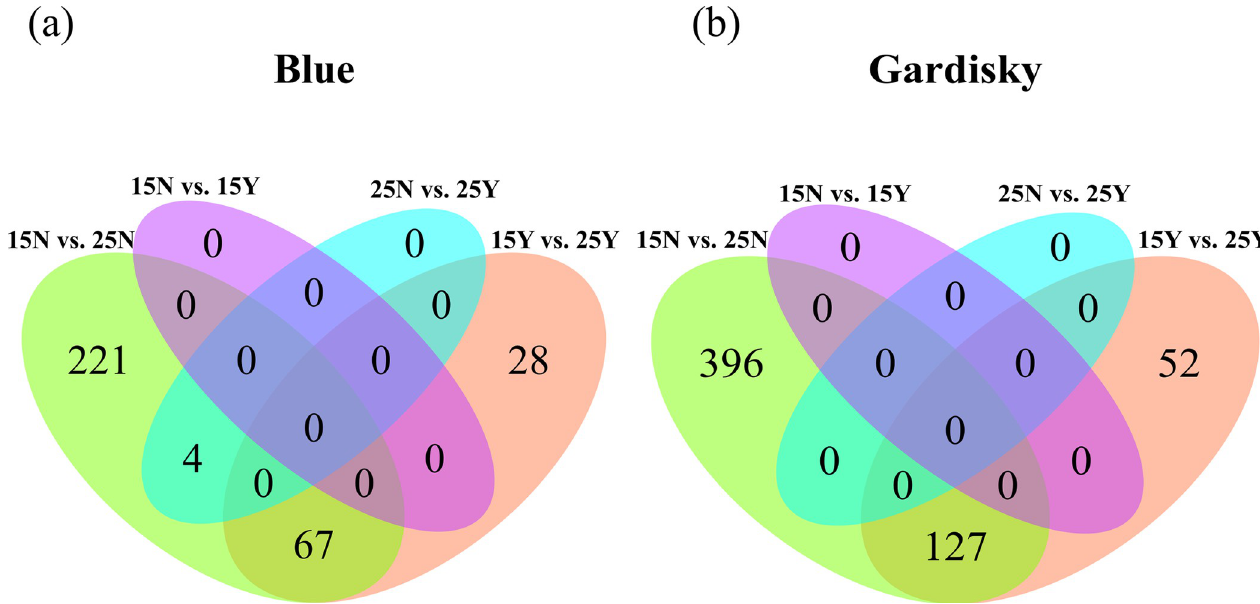
Fig 3. Many genes are differentially expressed in response to temperature changes, while kairomones have minimal observable effect at the level of transcript expression. Venn diagram of differentially expressed genes for Daphnia pulicaria clones (a) Blue and (b) Gardisky in response to temperature and predation cues. Cyan and purple sections illustrate differential expression from the introduction of predator cues (Y vs. N for the presence and absence of fish cues), while the green and orange sections illustrate differential expression due to temperature change. Treatment abbreviations: 15Y, 15˚C with kairomones; 15N, 15˚C without kairomones; 25Y, 25˚C with kairomones; 25N, 25˚C without